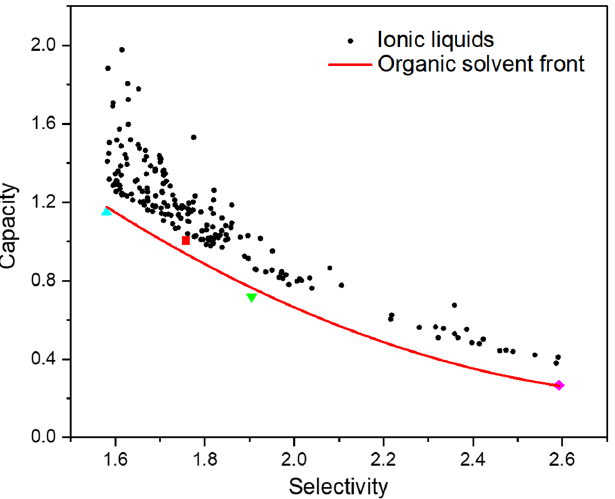
Figure 2. Screening of ILs with better extraction performance in contrast with the reference solvents (capacity of IL > capacity of organic solvents + 0.1).